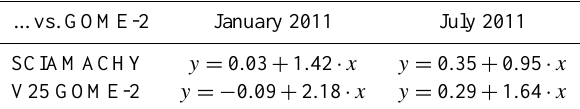
Table 2. Relationship between SIF values derived from GOME-2 and SCIAMACHY on a monthly basis to scale SCIAMACHY and V25 GOME-2 SIF values in Fig. 10. Shown is the linear fit (GOME- 2 SIF = intercept + slope · SCIAMACHY/V25 SIF) similar to those in Figs. 11 and